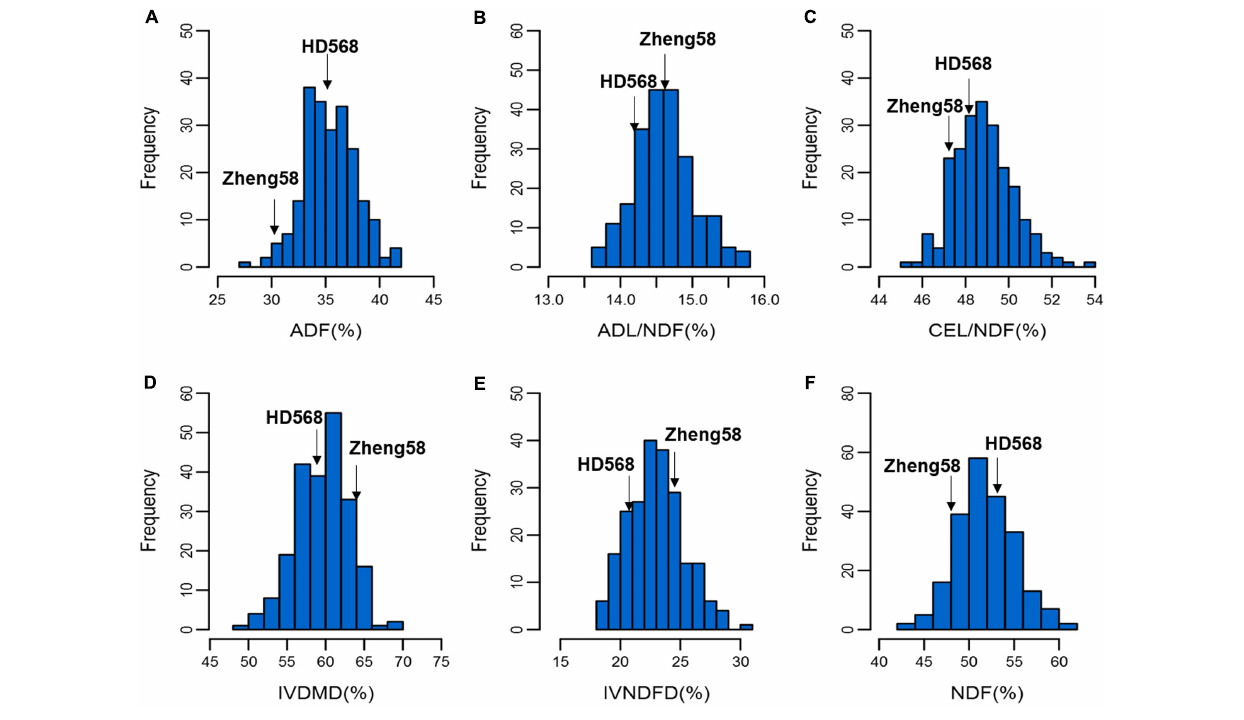
Frontiers in Plant Science |